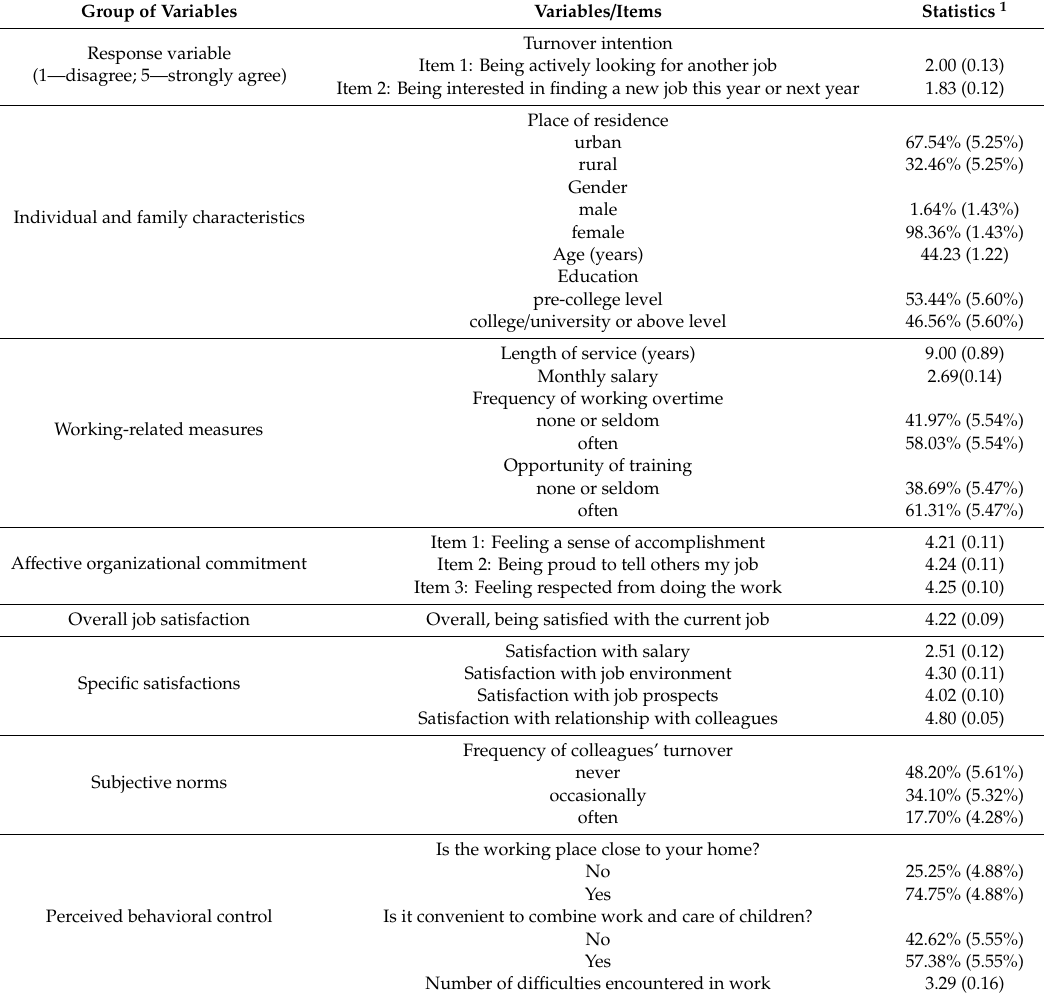
Table 1. Descriptive statistics of personal characteristics and other relevant